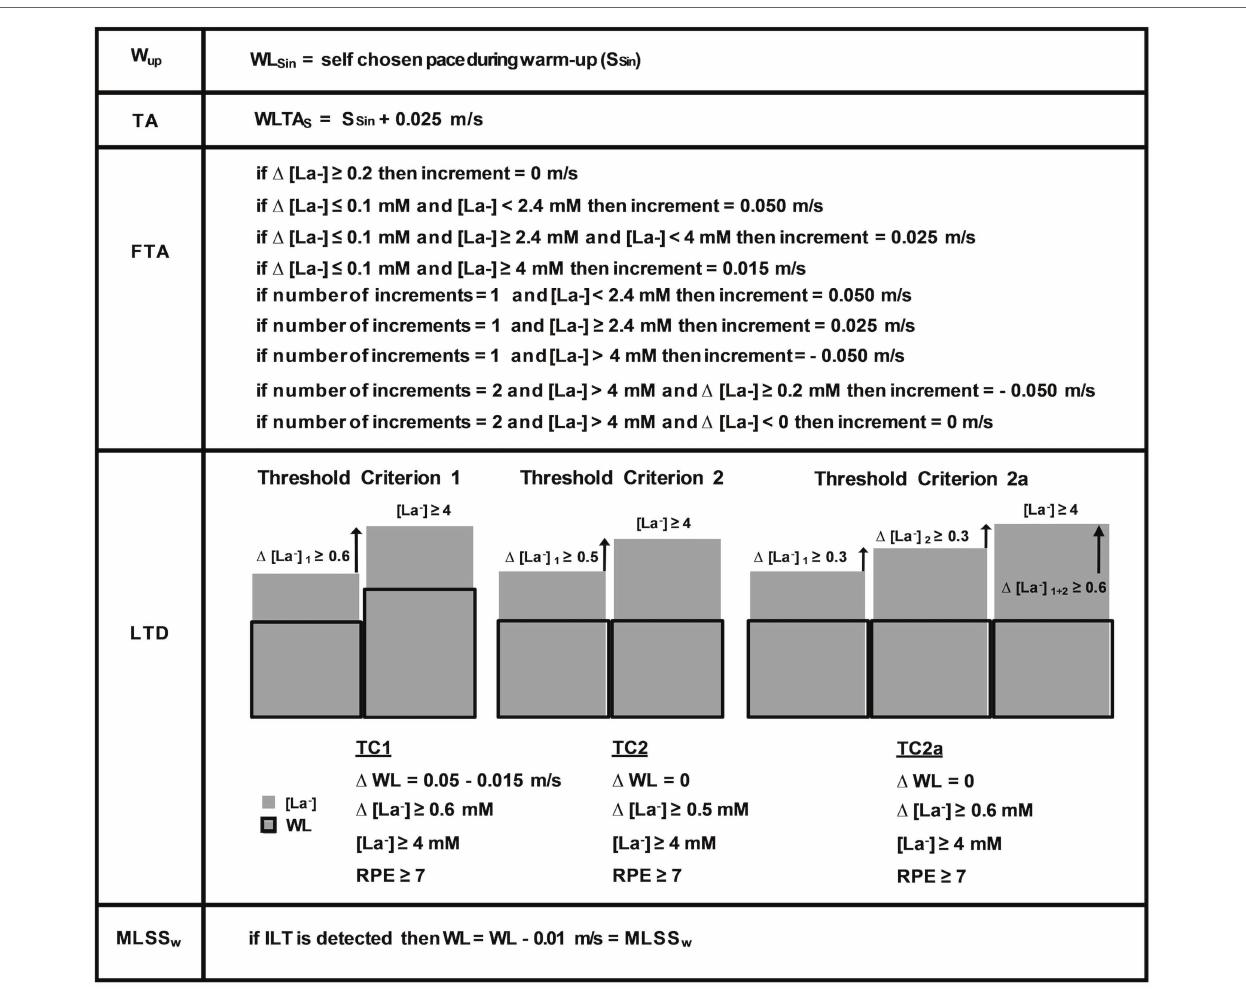
FIGURE 3 | ILT-test algorithms. Swimming pace (S Sin ) during warm-up (W UP ) was self-chosen. The fine threshold adjustment (FTA) was executed in accordance to test duration and blood lactate dynamics. The current threshold criteria (TC) 1, 2 and 2a for determination of the individual lactate threshold (ILT), have been developed into their current form by continuously incorporating ILT-test data. After determination of the individual lactate threshold (ILT), the lactate accumulation usually slowed down after a slight workload reduction indicating the MLSS W . [La − ], blood lactate concentration; MLSS W , maximal lactate steady state workload; RPE, rate of perceived exertion; and WLTAs, initial workload